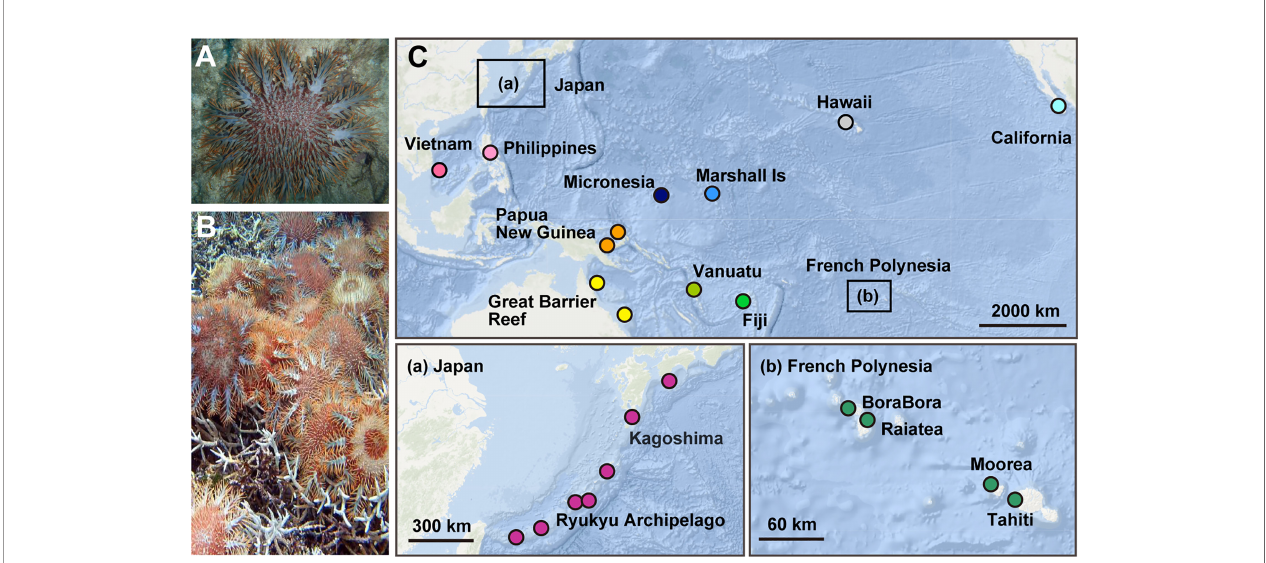
FIGURE 1 | (A) An adult of crown-of-thorns star fi sh (COTS) on reef-building corals. (B) An outbreak of COTS covering and eating scleractinian corals, causing severe damage to the reef. (C) Collection sites of COTS in the Paci fi c Ocean. 243 COTS were collected at 23 locations in 14 countries, representing 11 reef regions: French Polynesia (Bora Bora, Moorea, Raiatea and Tahiti), Fiji, Vanuatu, Great Barrier Reef of Australia (GBR; Clack and Shell Reefs), Papua New Guinea (PNG), the Philippines, Vietnam, Japan, Micronesia, the Marshall Islands, and USA (Hawaii and California). Locations in Japan and French Polynesia are enlarged in (a,